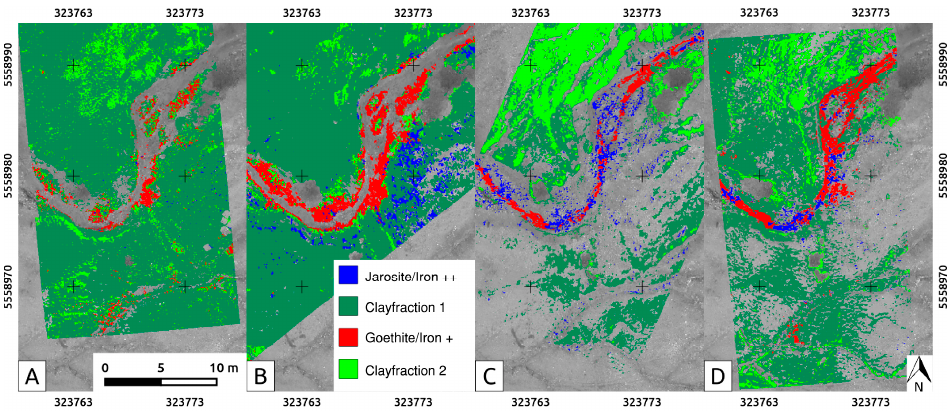
Figure 8. Results of two different classification approaches of two scenes, May 2016. Frames ( A , B ) display a waterfront scene, with band-ratio calculation and SAM classification, respectively. Frames ( C , D ) display the northern slope of the Litov area, first the SAM classification ( C ) followed by the band ratio ( D ). The endmember legend applies to ( B , C ). The legend in ( A , D ) is the dimensionless band-ratio of 720/880 nm.